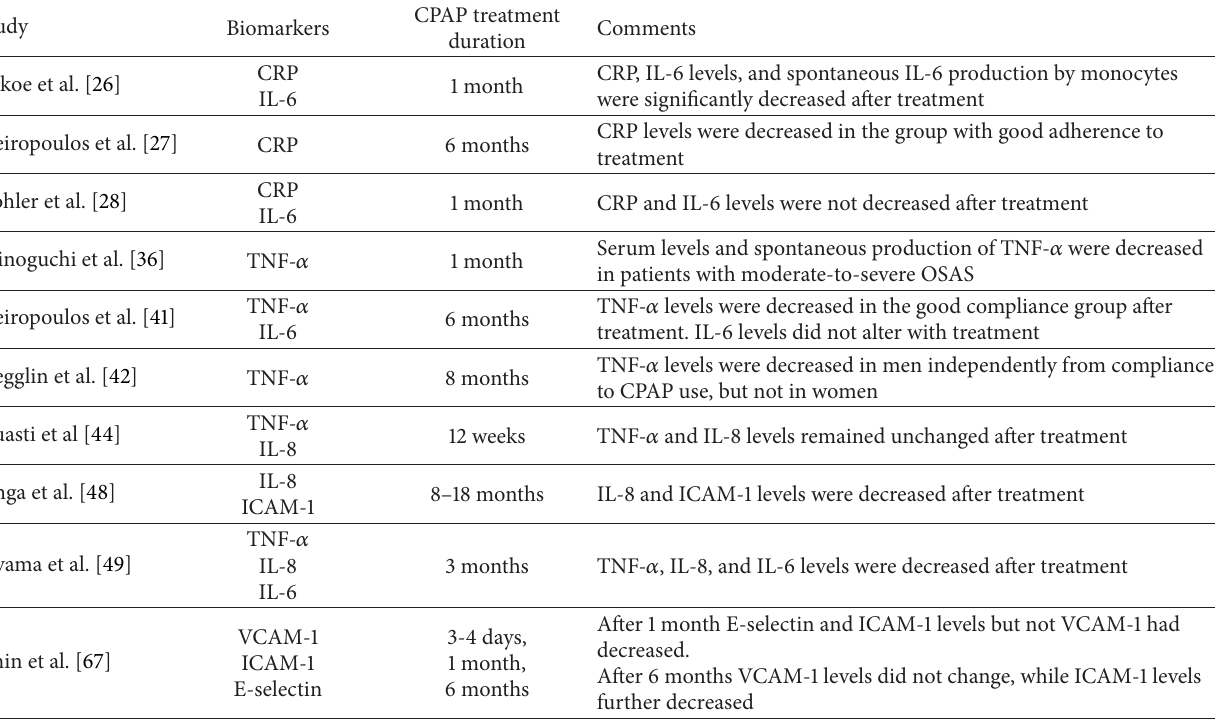
Table 2: Effects of continuous positive airway pressure treatment on several biomarkers in obstructive sleep apnea